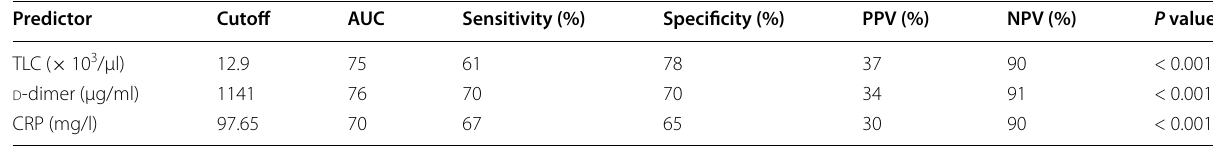
TLC Total leukocytic count, CRP C-reactive protein, PPV Positive predictive value, NPV Negative predictive value, AUC Area under the curve